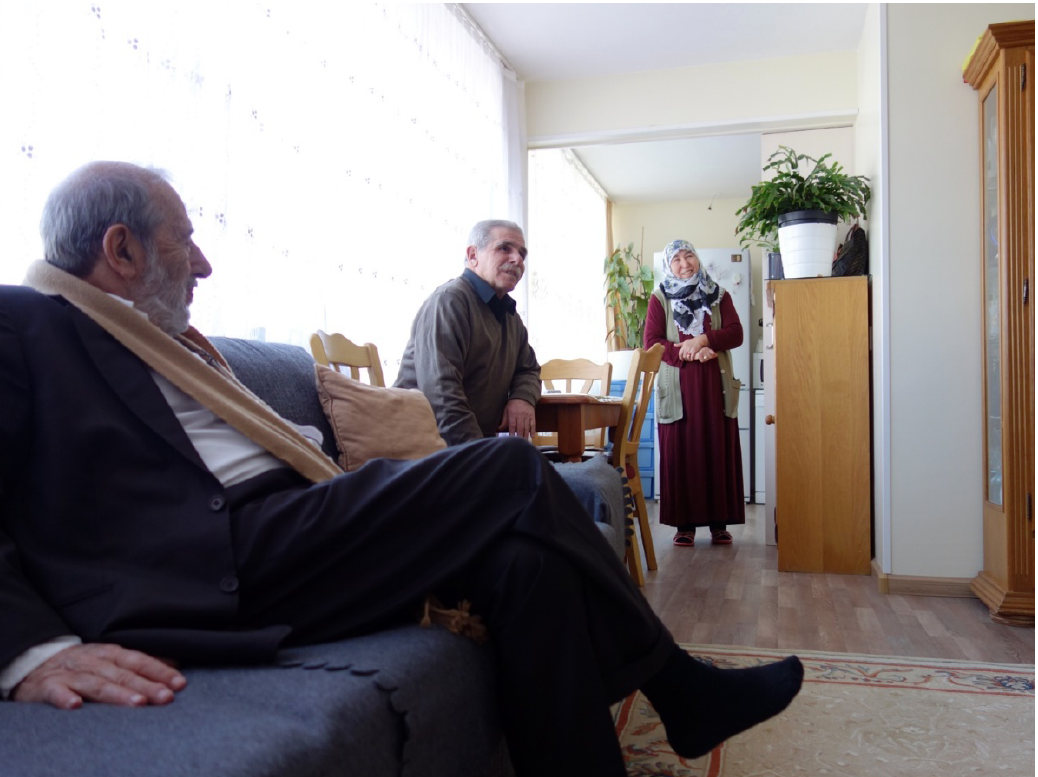
Figure 2. Álvaro Siza visiting a Turkish family living in the Schilderswijk neighbourhood, The Hague. The visit was organised as part of the preparations for the Portuguese pavilion at the 2016 Venice Biennale. Photographed by the